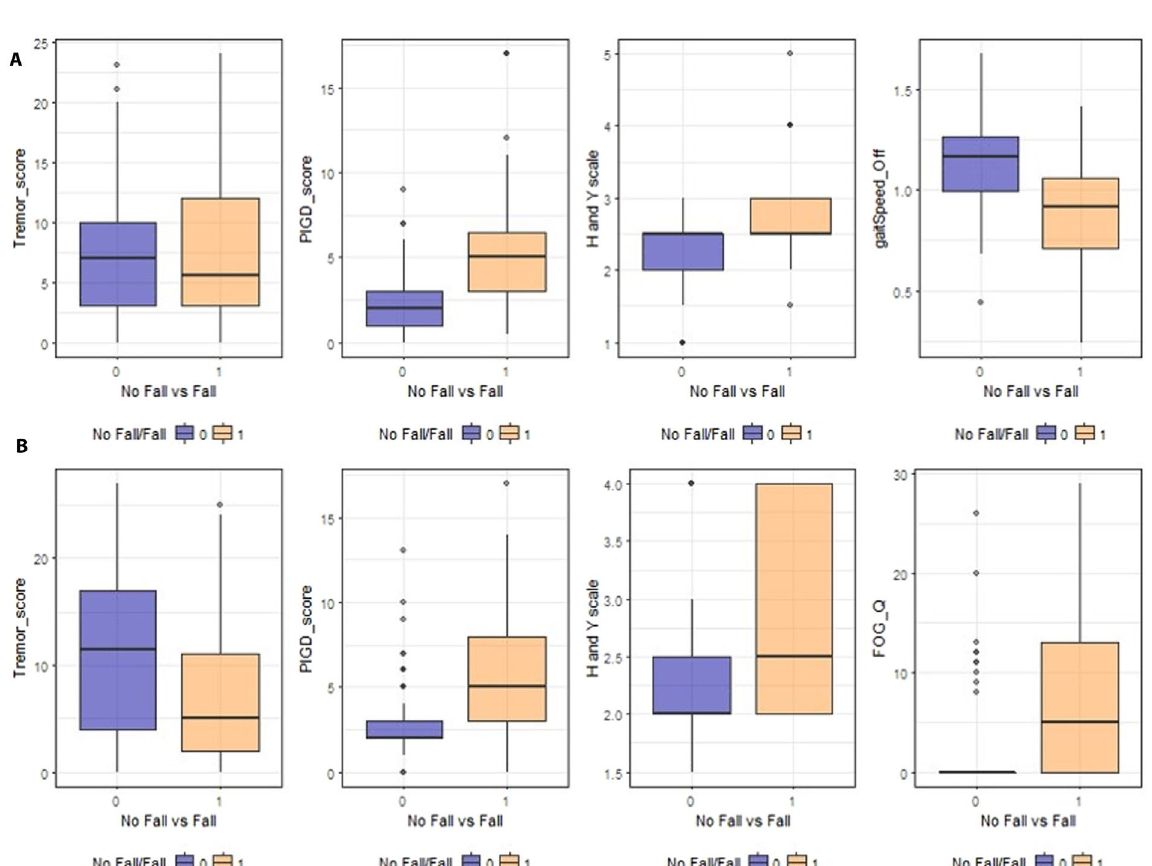
Figure 3. Exploratory data analytics illustrating some of the relations between falling and several clinical measures for the Michigan dataset ( A ) and the Tel-Aviv dataset ( B ),